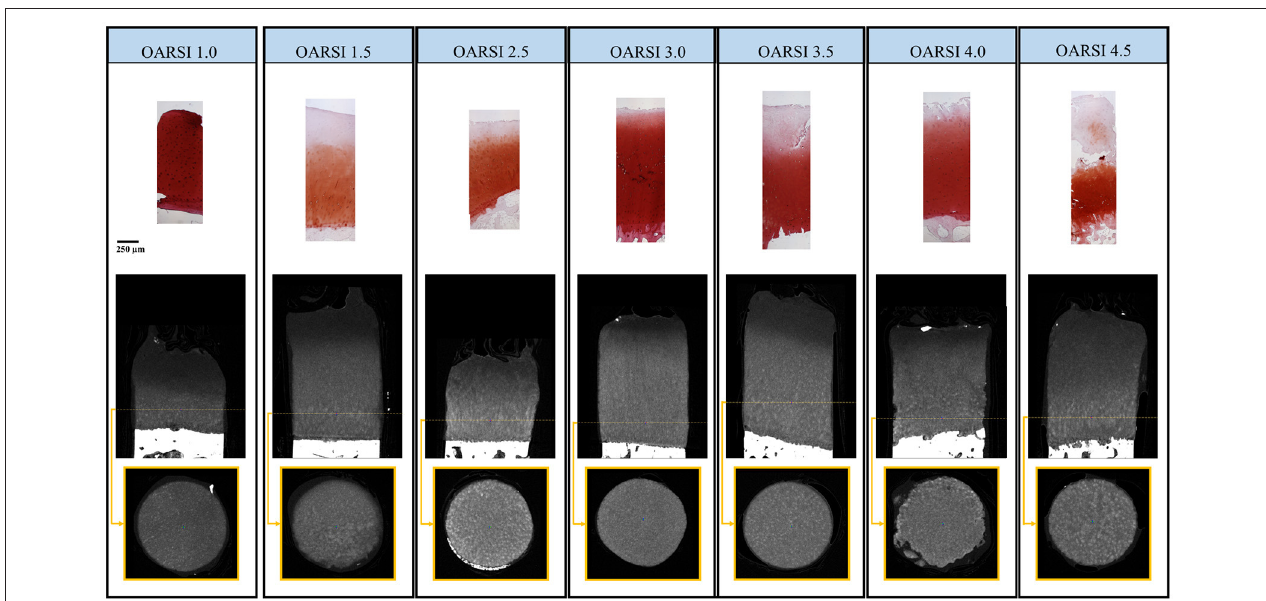
FIGURE 4 | The OARSI graded histological samples (Safranin O − stained, top row) compared to the adjacent samples stained with CA4 + and imaged with µ CT (middle row). The representative cross section (bottom row encircled with yellow box), from the deep zone (yellow dotted line) of the CA4 + stained plug shows varying micro-scale CA4 + accumulation. However the accumulation did not correlate with OARSI grading conducted from the adjacent histological cores. Histological slides and µ CT images are set to same scale. Global scale bar (250 µ m) under OARSI 1.0 – histological